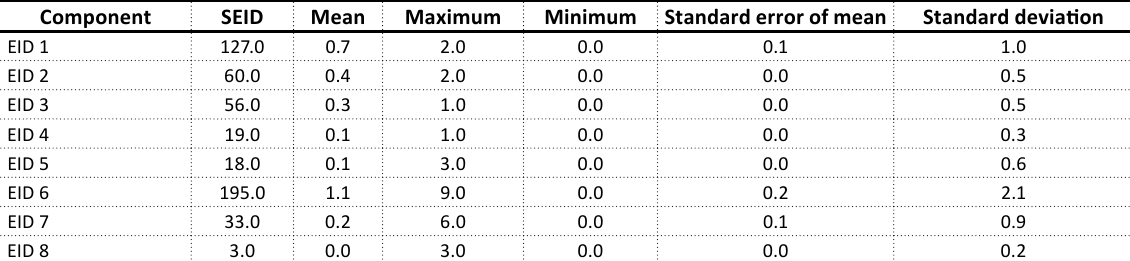
Source: Result of SPSS